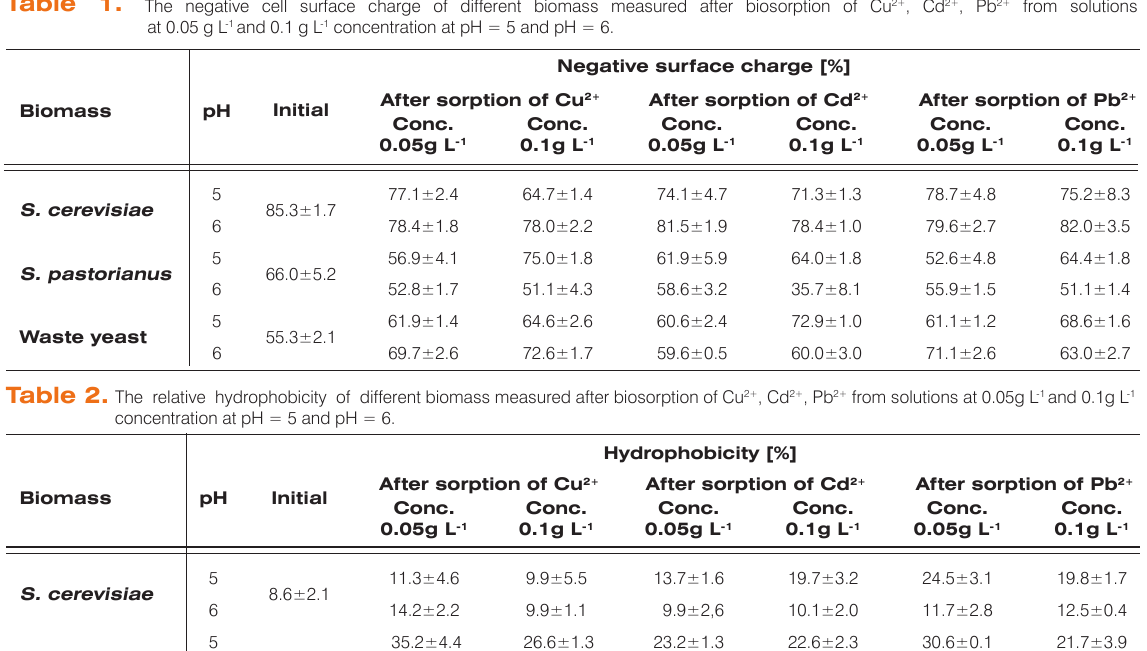
Table 1. The negative cell surface charge of different biomass measured after biosorption of Cu 2+ , Cd 2+ , Pb 2+ from solutions at 0.05 g L -1 and 0.1 g L -1 concentration at pH = 5 and pH = 6.